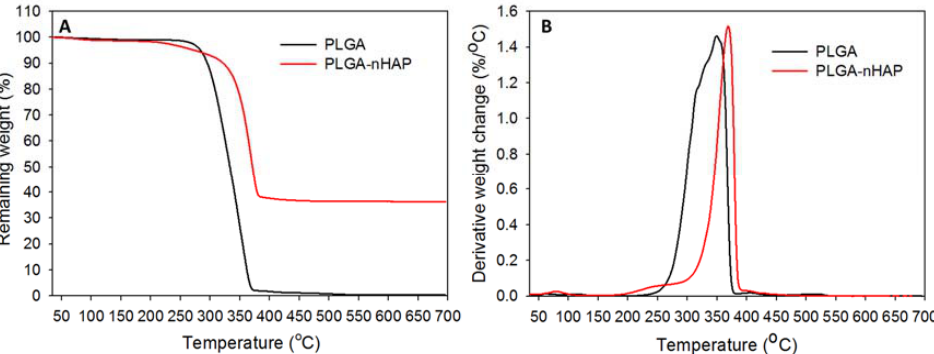
Figure 5. ( A ) Thermogravimetric analysis (TGA) and ( B ) differential thermogravimetric (DTG) analysis of PLGA microspheres and PLGA ‐ nHAP microsphere